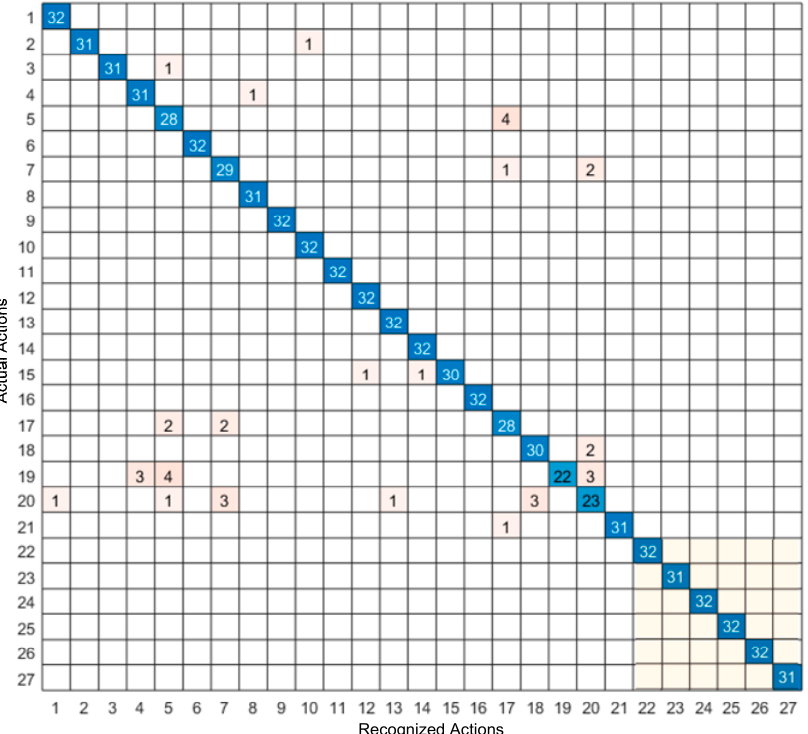
Figure 9. Confusion matrix of the decision-level fusion of video and inertial sensing modalities.